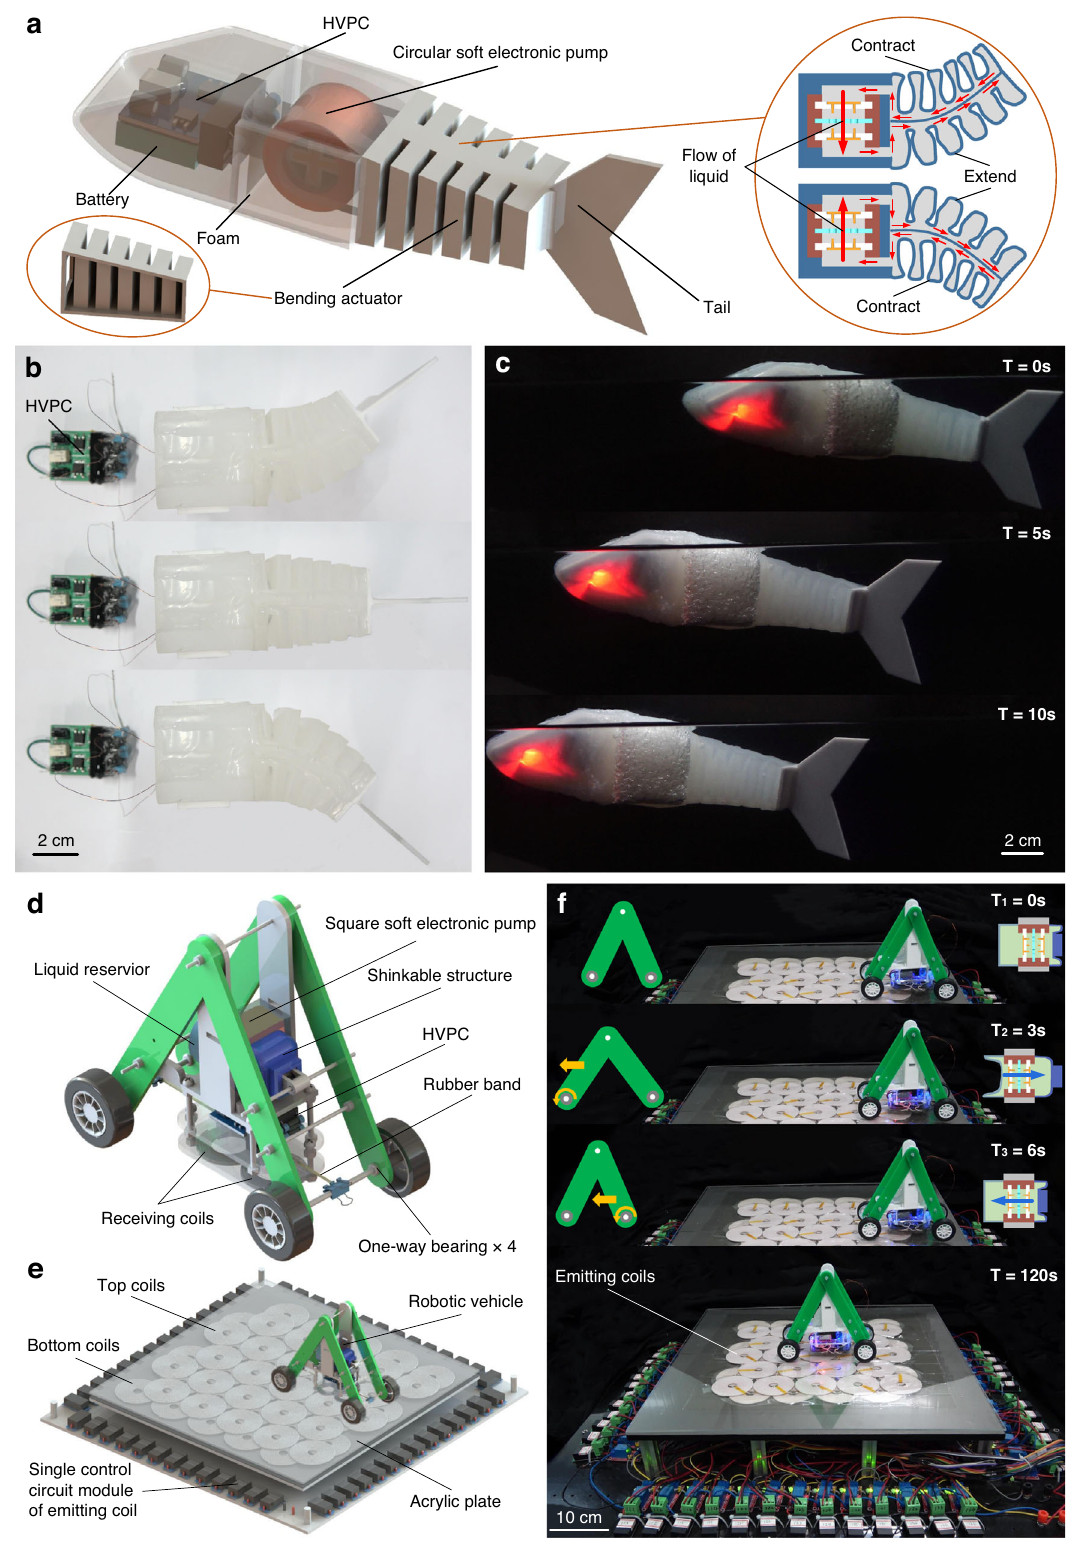
Fig. 4 Untethered robots powered by soft electronic pumps. a Design and operational principle of soft robotic fi sh. A circular soft electronic pump is implanted into the robotic fi sh to achieve the swing of the tail fi n. b Tail fi n actuation in air. c Time-lapse of the untethered swimming motion underwater of the fi sh. d Computer-generated rendering of the robotic vehicle. A square soft electronic pump is implanted into the robotic vehicle to achieve its forward motion. e Schematic of the robotic vehicle powered by the wireless power transfer system. The emitting coils are closely arranged in two layers, and the on/ off of the emitting coils is determined according to the position at which the robotic vehicle is at this moment and the next moment. f Time-lapse of the robotic vehicle moving on the top of the emitting coils. Schematics of the robotic vehicle are inserted in the upper left and right corner of each